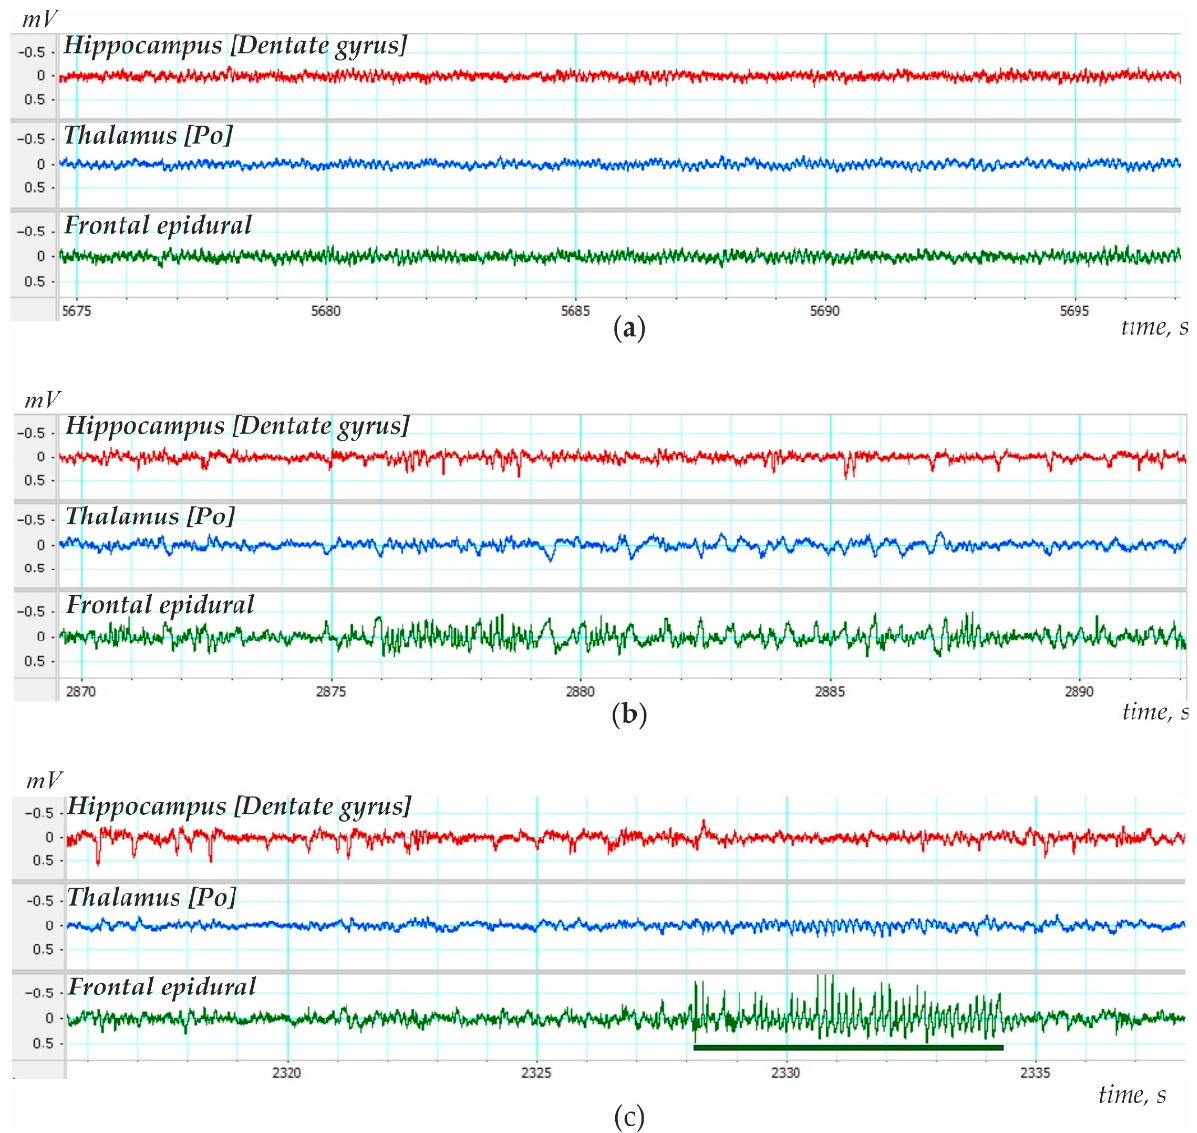
Figure 2. Electrical brain activity recorded in adult WAG/Rij rats with free behavior. ( a ) LPF/ECoG recording made during the desynchronized brain state characterized by low amplitude fast activity. ( b ) LPF/ECoG recording made during the synchronized brain state characterized by high amplitude slow wave activity. ( c ) LPF/ECoG recording during spontaneous spike ‐ wave discharges (SWDs, un ‐ derlined).